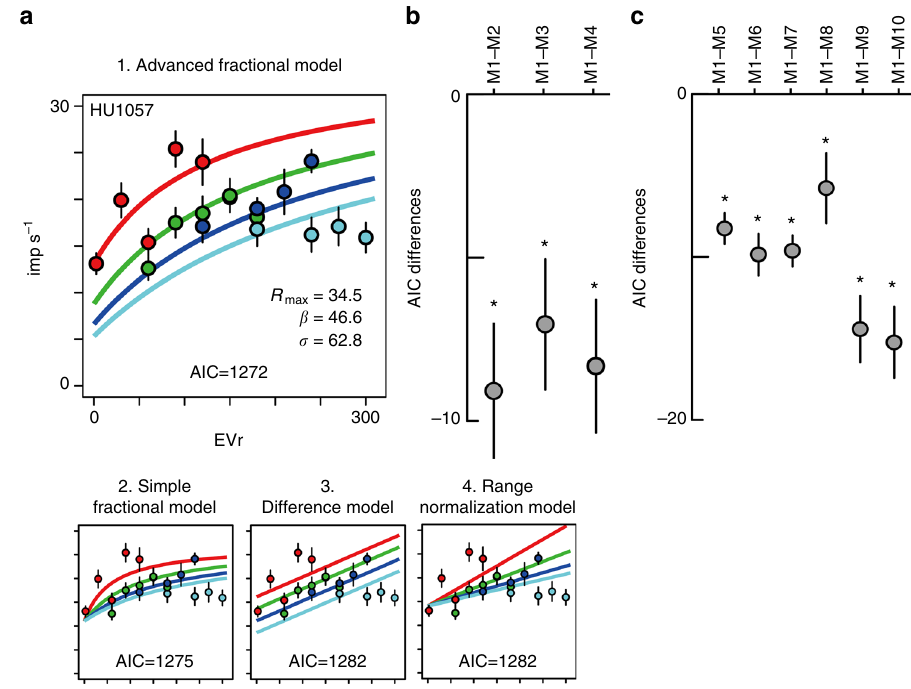
Fig. 4 The advanced fractional normalization model best explained mOFC relative value coding. a Four model outputs fi t to the example neuronal activity encoding relative value (same neuron as shown in Fig. 2a). Average fi ring rates and s.e.m. in 20 lottery pairs are plotted in each panel. Colored lines indicate the best- fi t lines segregated by payoff block. b Plots of the AIC differences between models estimated across the population. Mean and s.e.m. were estimated for 81 activities that showed relative value coding. AIC differences between model 1 and the other three relative expected value models are shown. c Same as b , but for AIC differences between model 1 and alternative models 5 – 10. See Methods for details of the models. Asterisk indicates statistical signi fi cance of the AIC differences from zero at P < 0.01 using one sample t -test